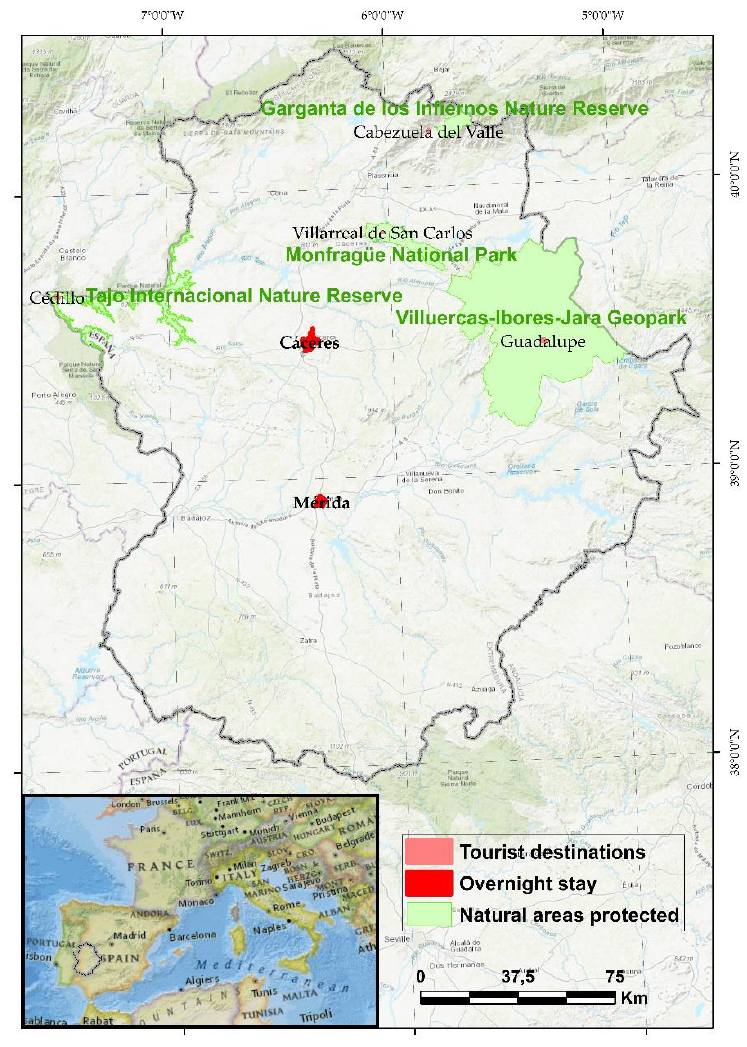
Figure 1. Study area.